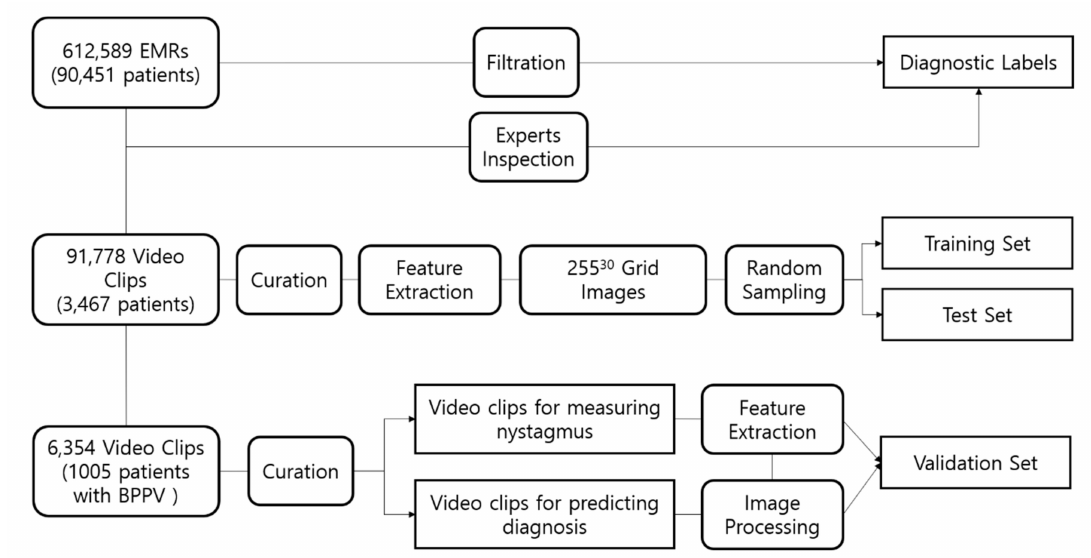
Figure 1. Data collection flow. Electronic medical records (EMRs) of 90,451 patients were filtered by keywords “vestibular function tests” and the video-clips recorded nystagmus were inspected by experts to obtain diagnostic labels for each patient. Among video-clips, those recorded nystagmus with typical movement on three axes were selected by experts and were used to create nystagmus directions for feature extraction (labels). Video clips of BPPV patients were used to generate the validation set for deep learning model. Grid images were randomly sampled using feature extraction, and the new set was split into training set and test set before training the